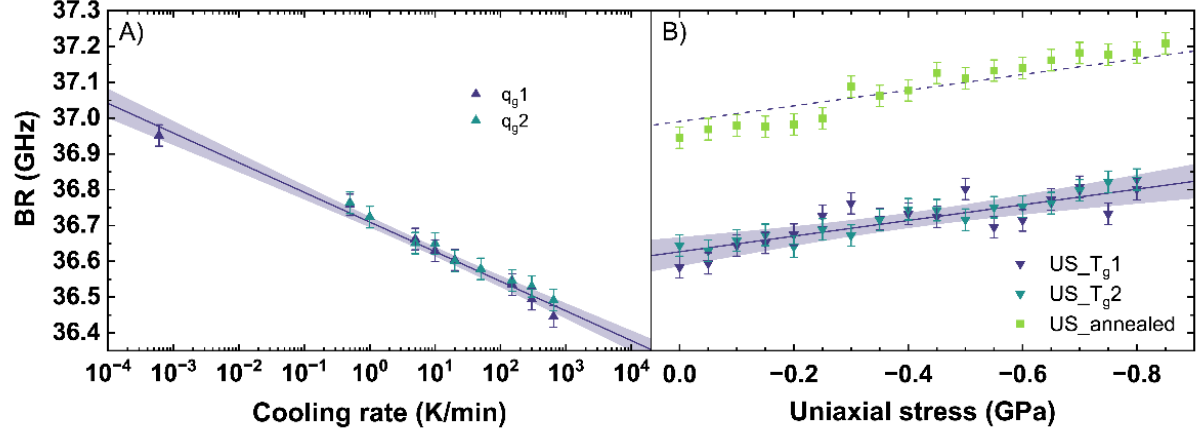
Figure 6. Brillouin shift ( BR ) in backscattering geometry with an excitation at 488 nm versus ( A ) cooling rate ( q g ) and ( B ) uniaxial stress ( US ). q g 1 and q g 2 are indicated by the dark blue and cyan up triangles. US_T g 1 and US_T g 2 are displayed by the dark blue and cyan down triangles. US_annealed is indicated by light green squares. The shaded areas show the 95% confidence interval of the linear fits.